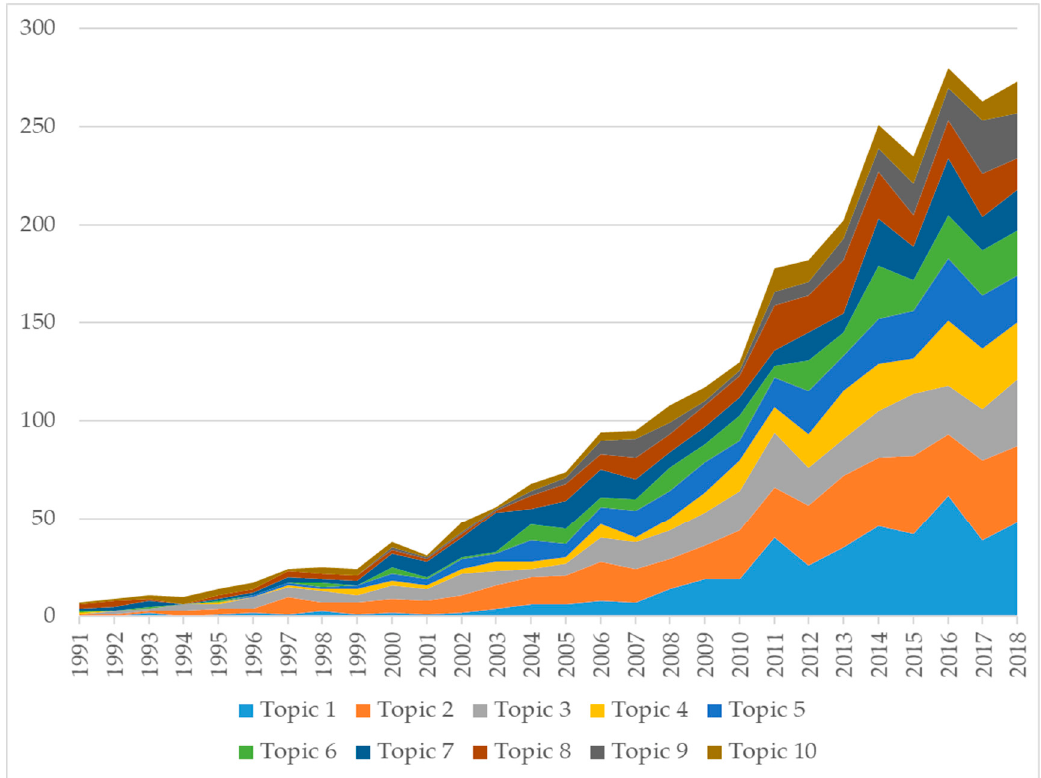
Table 4. Research topics classified by LDA.